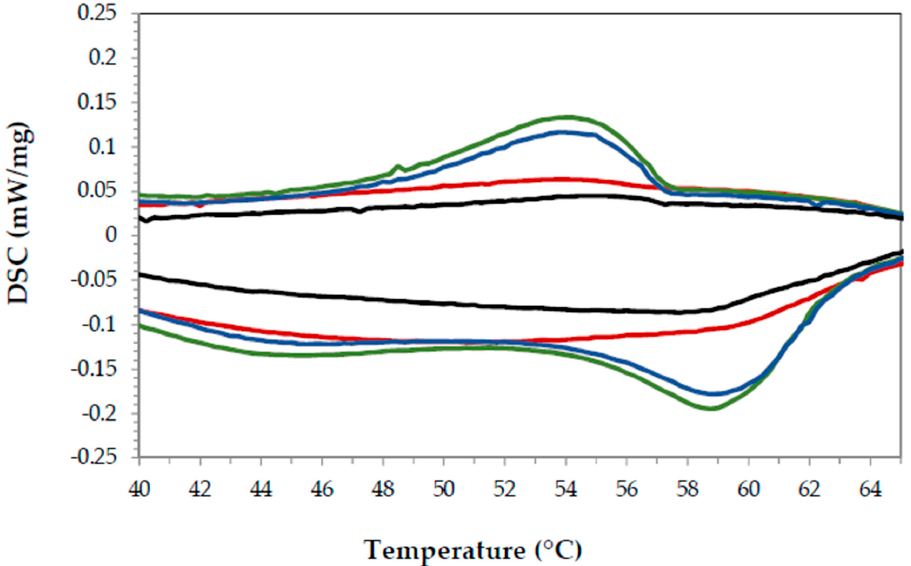
Figure 8. DSC results for samples 1 (red), 3 (green), 4 (blue) and 8 (black) from the Plackett-Burman experimental design for time 1 (10 min). Exothermic up, endothermic down. Table 5. Samples developed to analyze paraffin and Cu influence on thermal behavior (STD (±2% J/g)). Enthalpy % Cu % Paraffin (J/g)